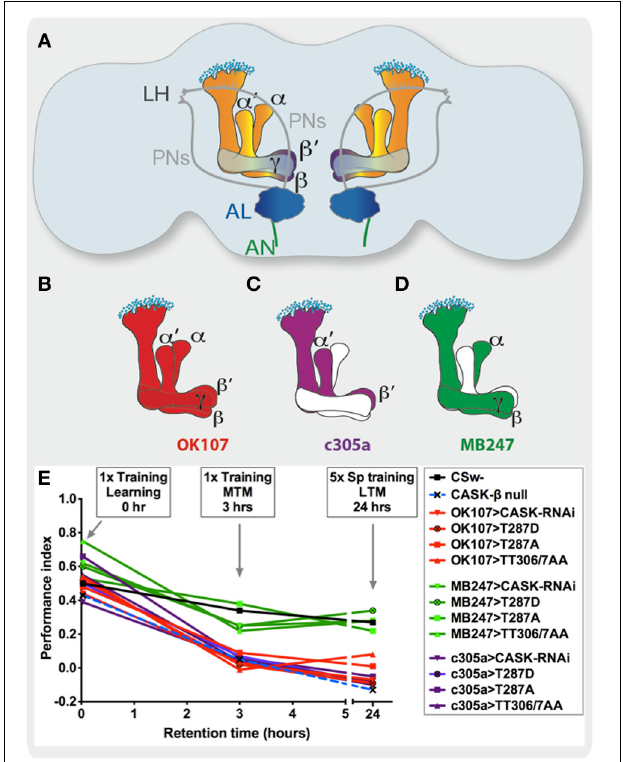
FIGURE 2 | CASK and CaMKII autophosphorylation function in the mushroom body α (cid:2) /ß (cid:2) neurons during middle and long-term memory formation. (A) A cartoon representation of a frontal section of the adult Drosophila brain showing subdivision of the memory circuit using Gal4 promoters that express in subsets of mushroom body neurons. Olfactory information (CS, conditioned stimulus) is relayed via the antennal nerve (AN) from the olfactory receptor neurons (the first order neurons) to the antennal lobe (AL, dark blue). This information is received in the glomeruli in the antennal lobe which represent the dendrites of the second order neurons, the projection neurons (PNs) send information to the higher brain centers: the mushroom body (the large lobed structures in the center) and the lateral horn (LH) neurons. The mushroom body consists of about 2000 neurons called Kenyon cells whose soma are depicted as small light blue circles. Drosophila mushroom bodies consist of three different classes of intrinsic neurons ( α / β , α (cid:2) / β (cid:2) , and γ ) that extend their axons into the five lobes of neuropil that are bilaterally symmetrically arranged in the center of the fly brain (Davis, 2011). (B) The OK107-Gal4 promoter expresses in all mushroom body neurons and a number of neuronal regions outside the mushroom body (in red, Connolly et al., 1996). (C) While c305a-Gal4 (in purple) promoter expresses in the mushroom body α ’/ β ’ neurons as well as other regions (Krashes et al., 2007; Pech et al., 2013) and (D) MB247-Gal4 (in green) expresses in mushroom body α / β and γ neurons (Zars et al., 2000). (E) By measuring memory at different times after training, memory retention curves readily depict the effect of each genotype on memory performance (Performance index) . Learning or initial (2min) short-term memory (STM) was measured immediately after administering one cycle of shock-odor training, no statistical difference in learning was seen between CASK and CaMKII genotypes with wildtype ( CSw- in black). MTM measured 3h post-one cycle training was completely removed in CASK- β null (light blue dashed line) flies. Likewise targeted expression of CASK-RNAi (downward triangle), constitutively active CaMKII-T287D (black circle with cross in), Ca 2 + dependent CaMKII-T287A (square)